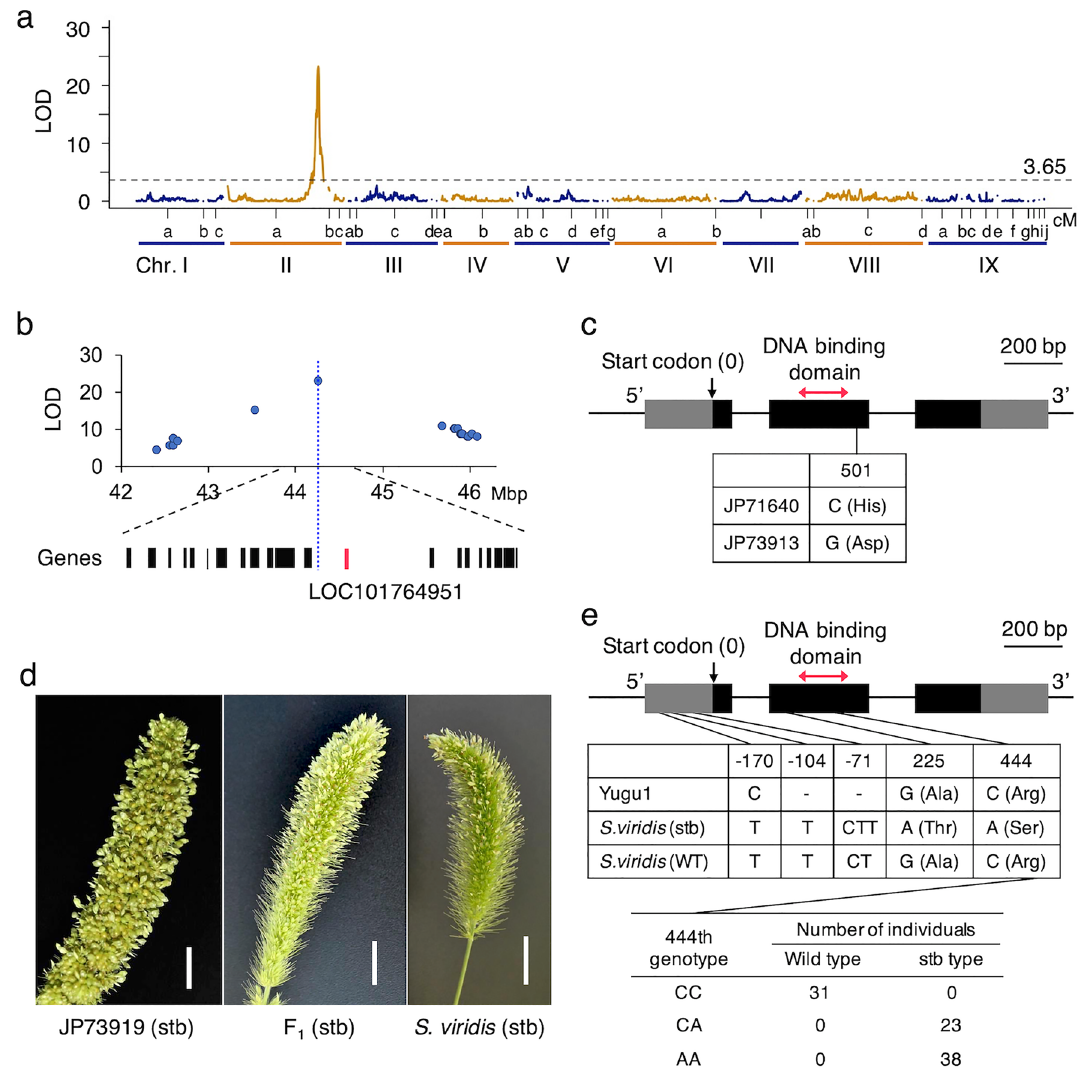
Figure 5. Analysis of spikelet tipped bristles (stb) in foxtail millet. ( a ) Distribution of LOD scores for stb in RILs. ( b ) Enlarged view of the physical map around the marker which showed the highest LOD score. The annotated genes on the S. italica reference genome are shown at the bottom part, and the red one is HOX14 which is the candidate gene for stb. ( c ) Structure of HOX14 gene, a candidate gene for stb phenotype. A non- synonymous SNP presents in the exon 2. ( d ) Allelism test using cross between JP73913 and ‘Kyoto stb-1’ that is stb mutant of S. viridis . These two accessions and F 1 hybrid between them showed stb phenotype. White bar indicates 10 mm. ( e ) Structure of HOX14 gene. Two SNPs specific to Kyoto stb-1 ( S. viridis ) are present in the exon 2 (middle table). The reference genome sequence of S. viridis , A10.1 5 , was used as the wild-type (WT) sequence. The 444th SNP genotype in F 3 individuals derived from a cross between Yugu1 and ‘Kyoto stb-1’ correspond to stb phenotype (bottom